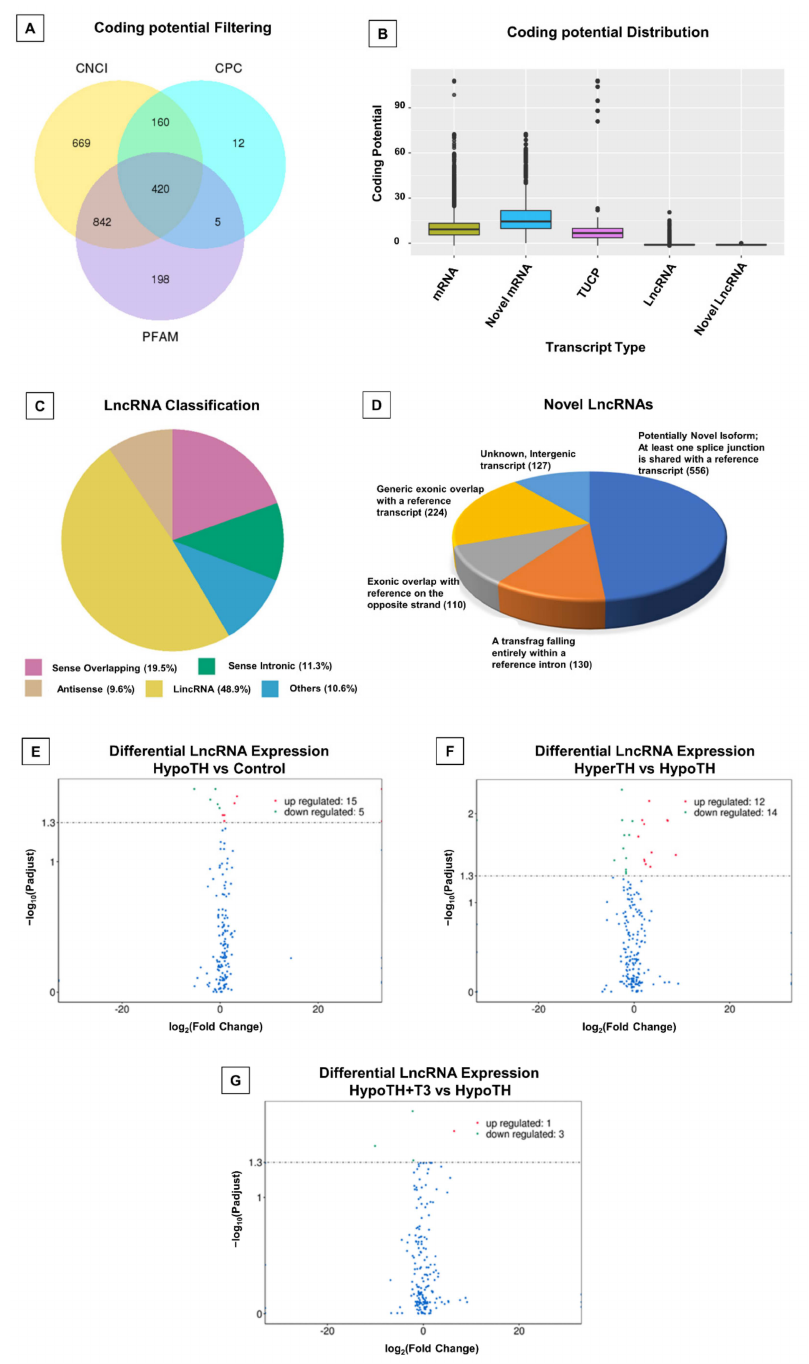
Figure 3. Novel and significant lncRNA alterations in TH dysfunction and restoration: ( A ) Coding potential Filtering: Numbers in each circle and overlap represent the respective total and shared num- ber of predicted noncoding transcripts; ( B ) Coding potential distribution; ( C ) LncRNA classification; ( D ) Novel lncRNAs and different subtypes; ( E – G ) Differential LncRNA Expression Analysis of ( E ) Hy- poTH vs. Control ( F ) HyperTH vs. HypoTH and ( G ) HypoTH + T3 vs. HypoTH groups. Targets with adjusted/corrected p < 0.05 were considered statistically significant; LncRNA-Long noncoding RNA; CNCI: Coding-Non-Coding Index; CPC: Coding potential Calculator; TUCP: Transcripts of uncertain coding potential; HyperTH: Hyperthyroidism; HypoTH: Hypothyroidism; T3: